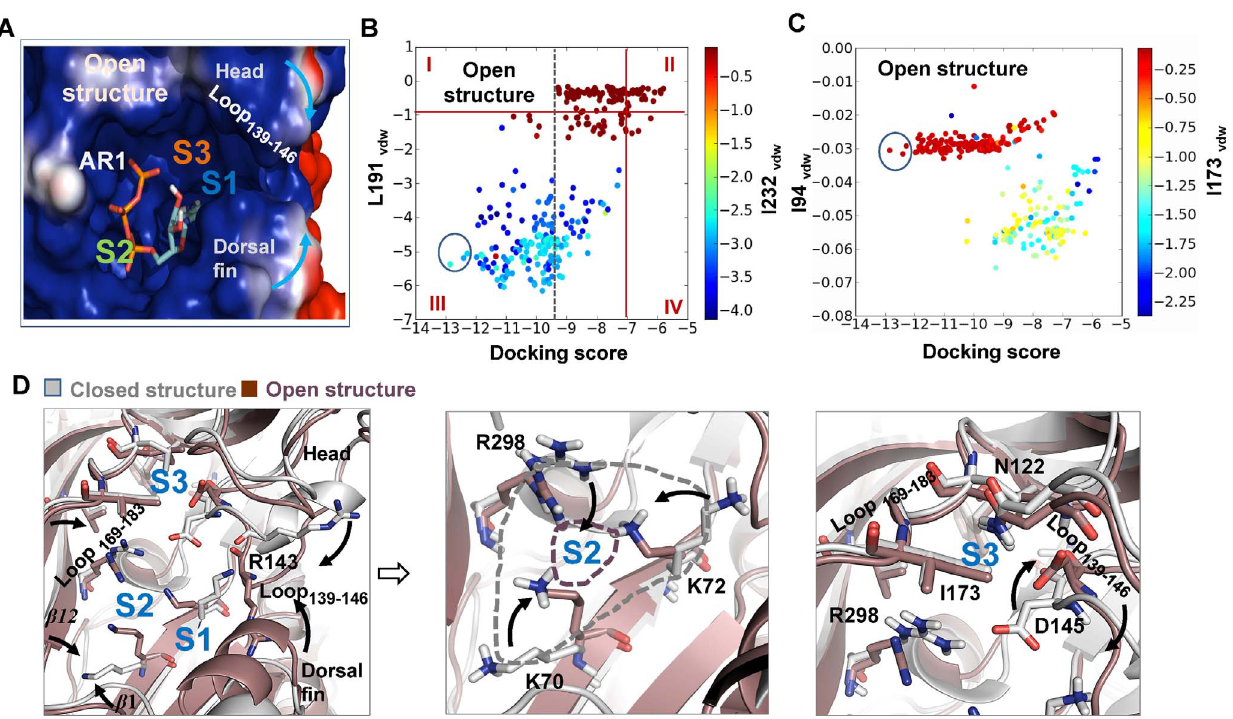
Figure 6. AR1’s occurrence gives rise to a decreased preference of ABP for AR2 and 3. ( A ) AR1 mode in the open structure (PDB entry code: 4DW1). S1, S2 and S3 indicate three potential sites contacting with the adenine ring of ATP. ( B–C ) Summary of poses in opening structure of zfP2 X 4. The docking scores and vdW scores of L191, I232, I94 and I232 of per poses were calculated by Glide [34]. Each dot represents a pose of ATP. The colors of dot indicate vdW scores of I232 ( B ) or I173 ( C ). The blue dot means strong vdW contacts between ATP and L191 ( B ) or I173 ( C ). The top poses of each sampled conformation of receptors were highlighted within cycles. ( D ) Superposition of closed (grey, PDB entry code: 3H9V) and open structures (light brown, PDB entry code: 4DW1). Black arrows denote the movements of key domains/regions and residues (displayed in sticks for emphasis) from the resting to open structures. The changed sizes of site S2 in closed (grey) and open (brown) structures are highlighted with dotted